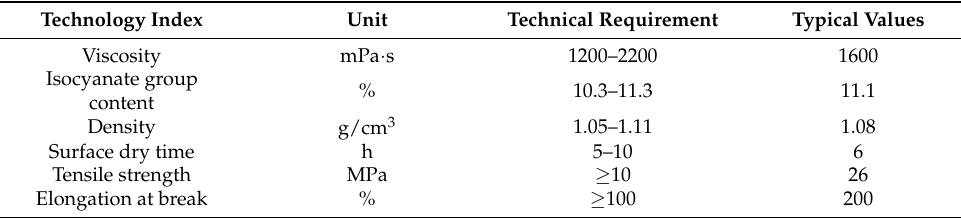
Table 1. Technical indexes of PU binder [34].